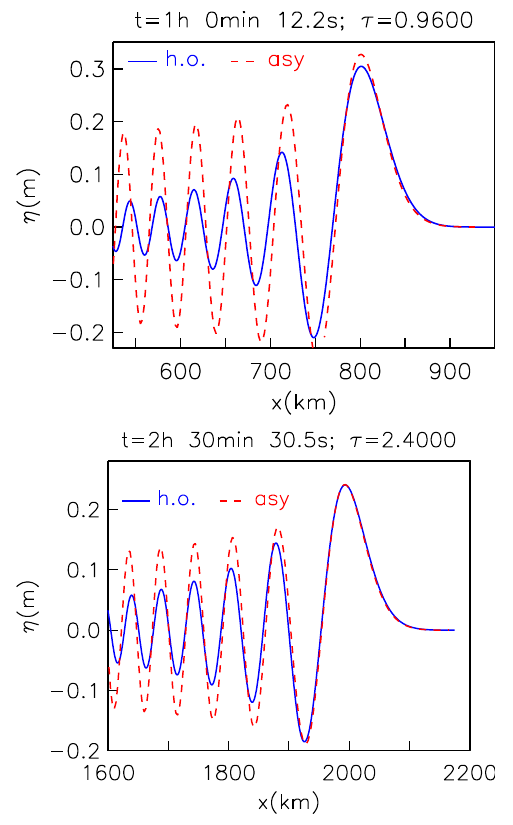
Fig. 7. The surface elevation for plane simulations. Comparison of dispersive simulation (h.o.) and the asymptotic formula (8) for the wave front. The phase of the latter is adjusted to yield coinciding leading peaks at t = 37 . 5min. Waves are propagating to the right.